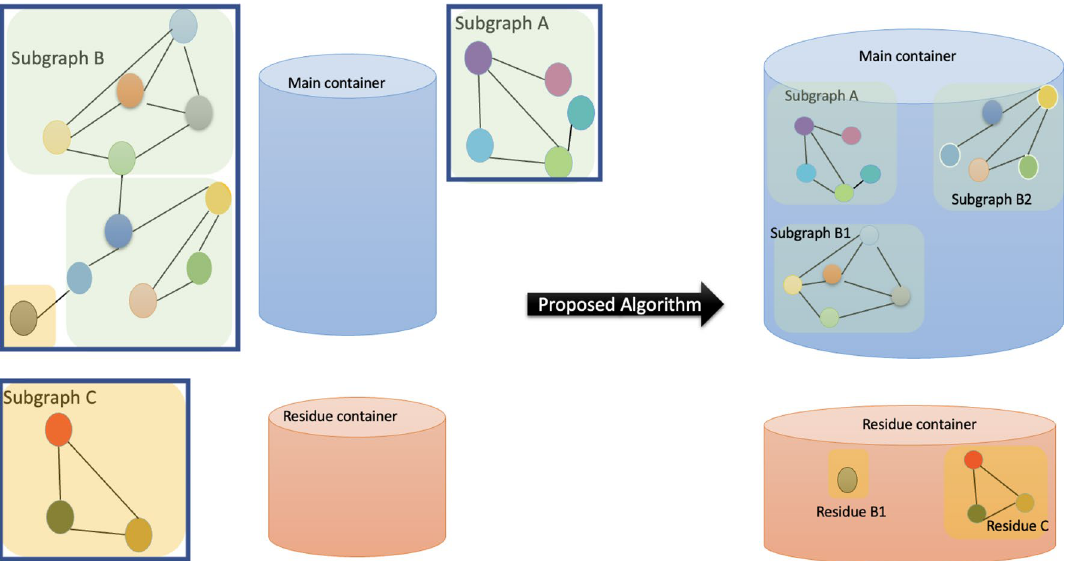
Figure 4. Framework to extract subgraphs of size w for dynamic user data. The proposed algorithm GEDD first converts large components into smaller subgraphs of size w with a residue. The optimal and adjusted graphs are added to the main container and the residue subgraphs of size < w are to the residual container. In the end, the residual graphs are processed to obtain the required size w graphs. The figure was drawn by the corresponding author in Microsoft PowerPoint, version 16.70 available at https:// www. micro soft. com/ en- us/ micro soft- 365/ power